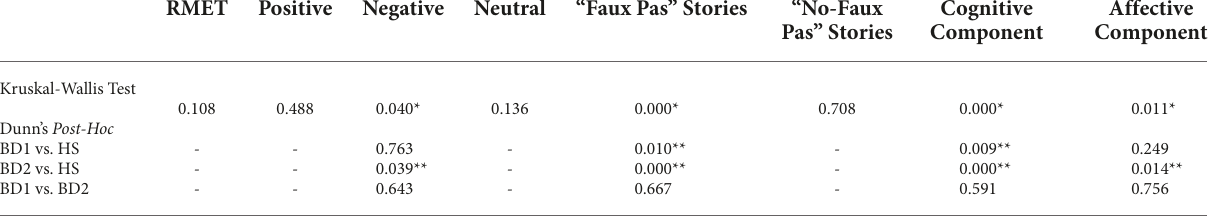
TABLE 4 Results of statistical analysis between BD1, BD2, and HS in the ToM tests. RMET